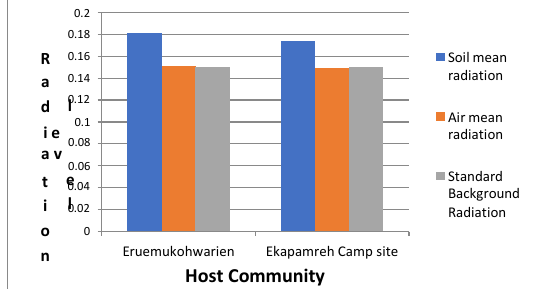
Figure 4: Correlation of mean radiation levels (μSv/hr) for soil and air with the standard background radiation in the Eruemukohwarien and Ekakpamreh host